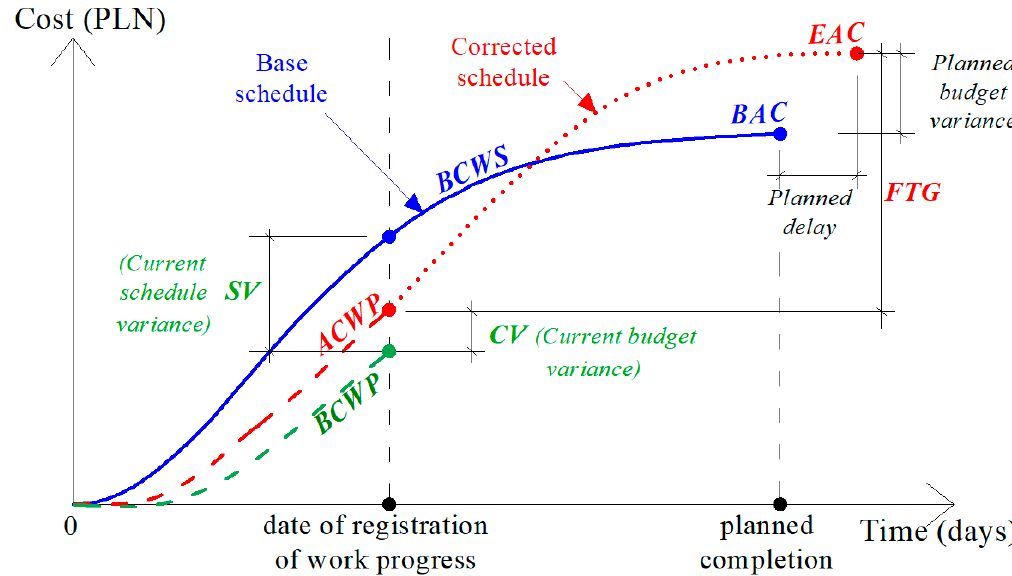
Figure 1. Elements of earned value method (EVM) (description in text). Source: [19].